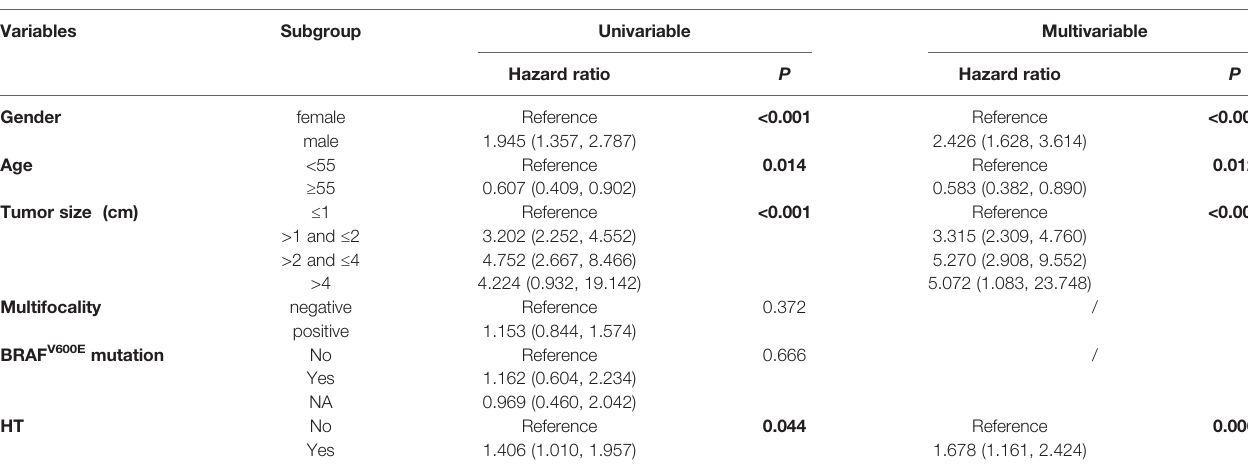
TABLE 3 | Univariate and multivariate analysis of 747 PTC patients for